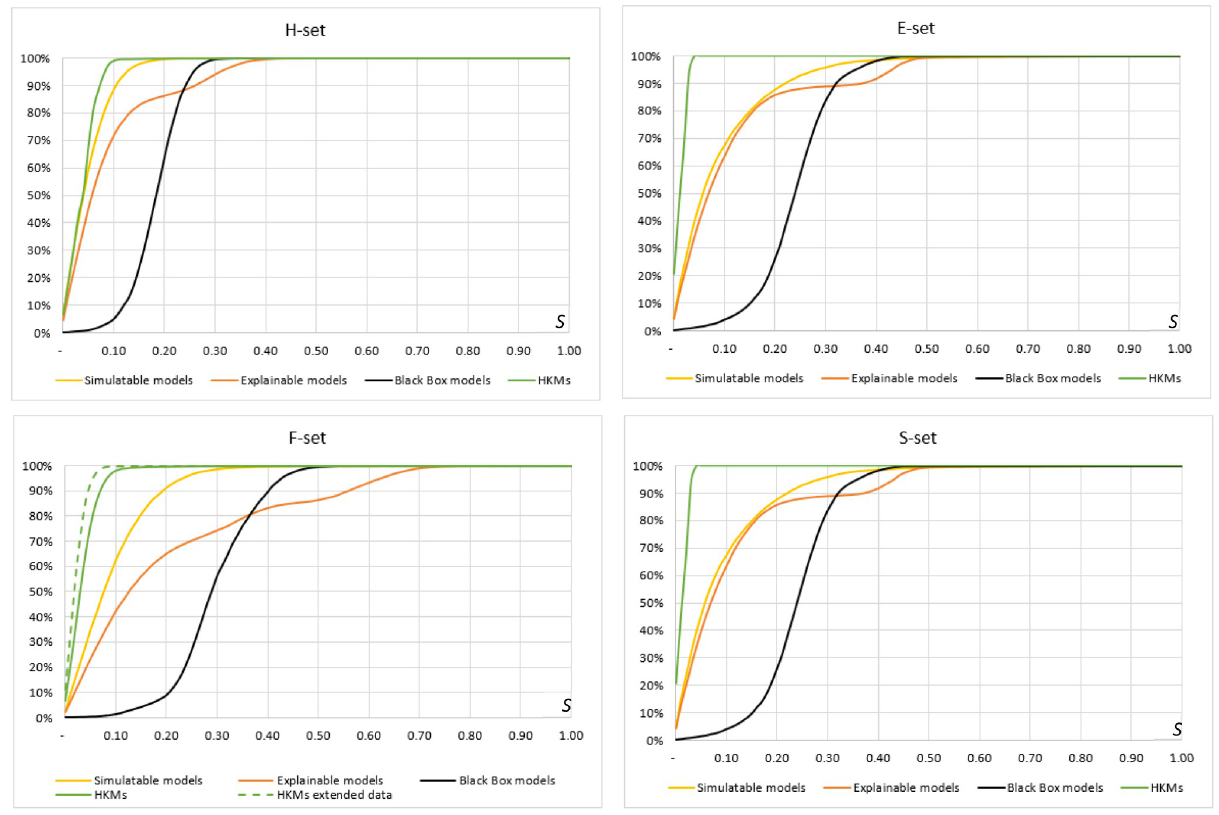
Fig 4. Model stability P(S) as a function of model quality threshold S (S varying from 0 to 1 in F 1 metric).